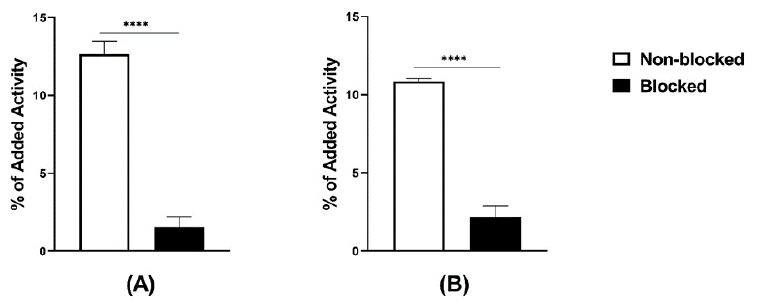
Table 1. Affinity measurements of [ 99m Tc]Tc-maSSS-PEG 2 -RM26 and [ 99m Tc]Tc-maSES-PEG 2 -RM26. Figure 2. In vitro binding specificity tested on PC-3 cells, ( A ) [ 99m Tc]Tc-maSSS-PEG 2 -RM26 and ( B ) [ 99m Tc]Tc-maSES-PEG 2 -RM26 with and without prior GRPR blocking. The error bars represent the